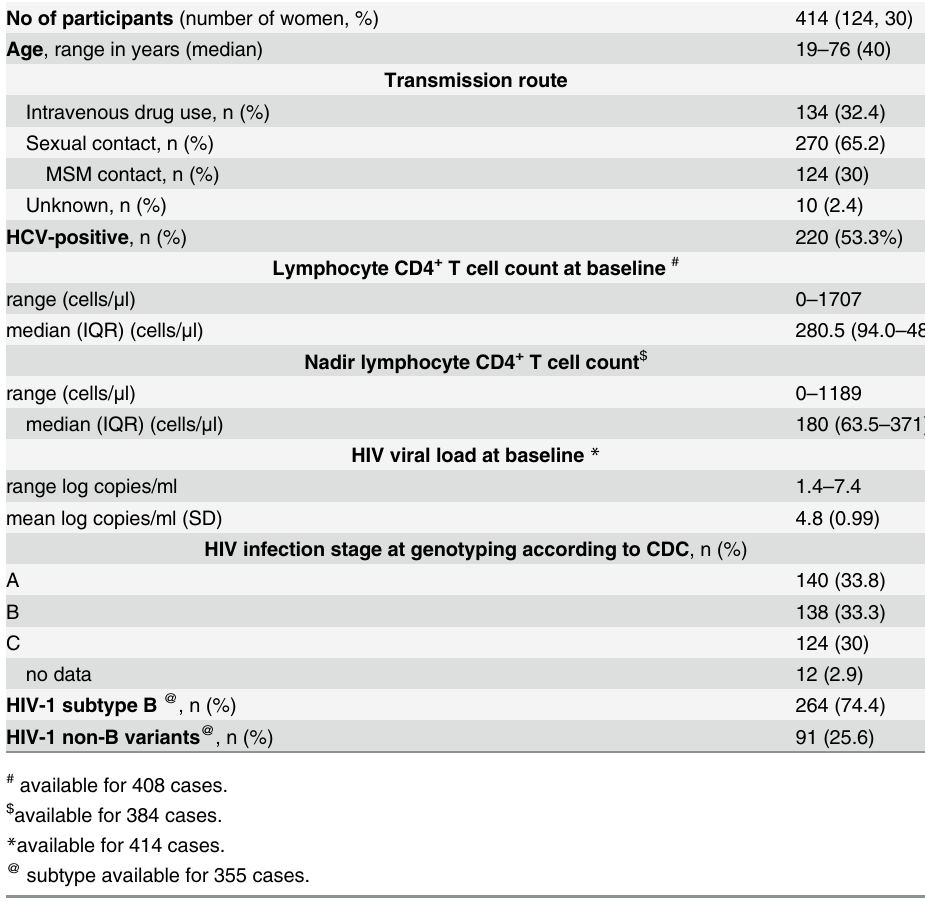
Table 1. Characteristics of the study